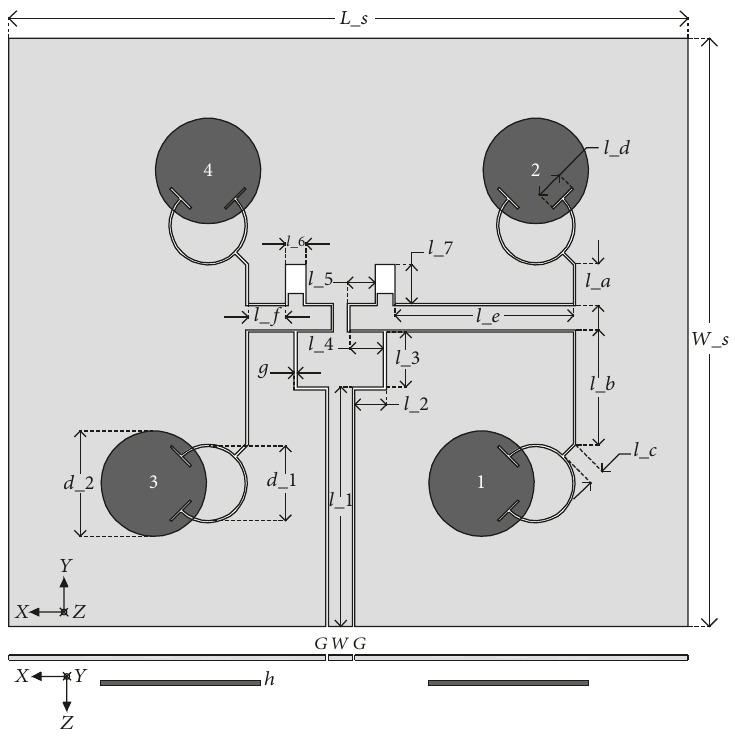
Figure 5: The geometry of the 2 × 2 antenna array.